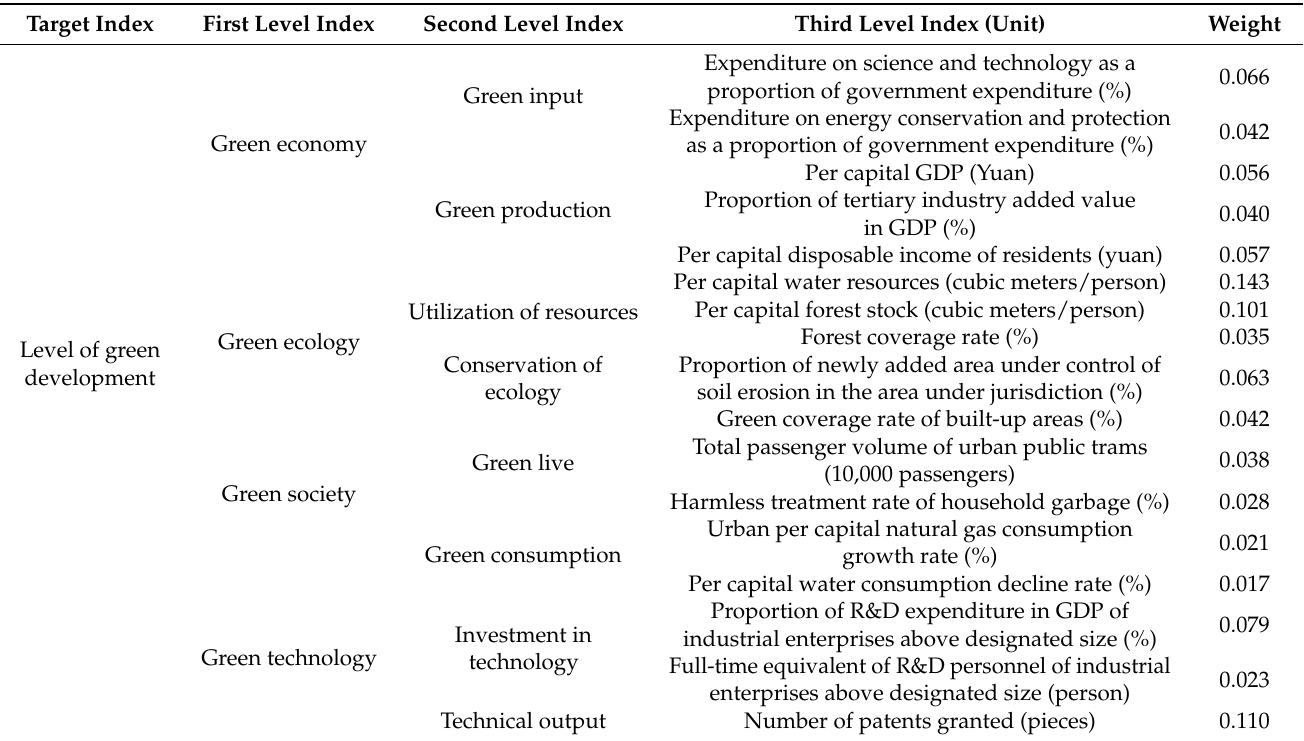
Table 1. The index system of green